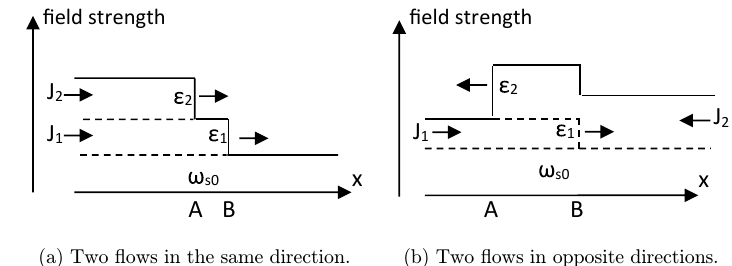
Fig. 10. Sound °ows and